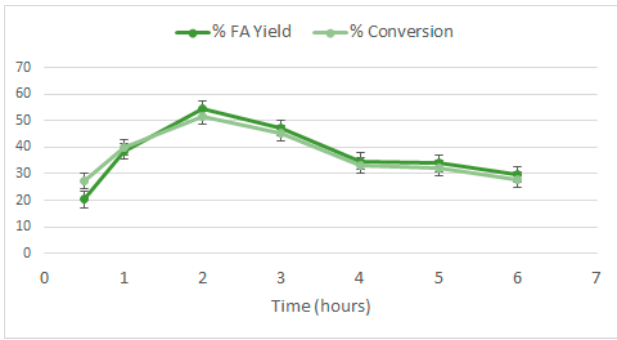
Figure 10. Furfural oxidation in CSTR employing Au/HT 4:1 as catalyst. p = 5 bar air; t = 110 °C; FF/Au = 50; feed: 0.5 mL min − 1 [FF] = 26 mM; 100 mg of catalyst.